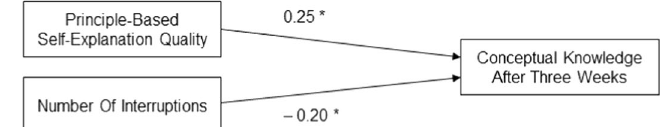
Fig. 5 Regression on conceptual knowledge after 3 weeks. Standardized beta coefficients, * p <